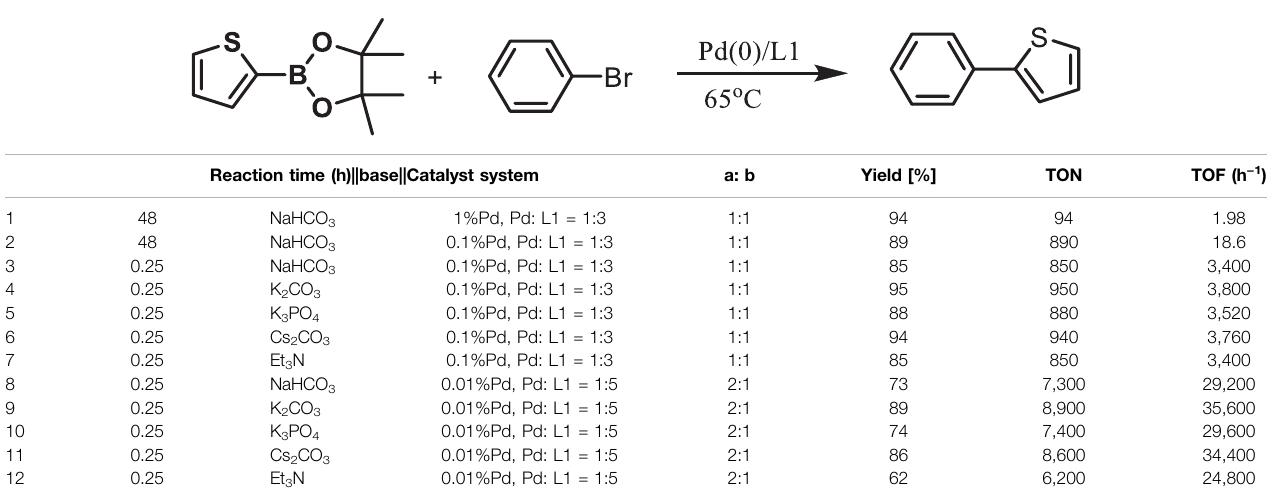
TABLE 1 | Yields of the isolated products from Suzuki – Miyaura cross-coupling reactions of thiophene-2-boronic esters (a) and bromobenzene (b) under various reaction conditions.